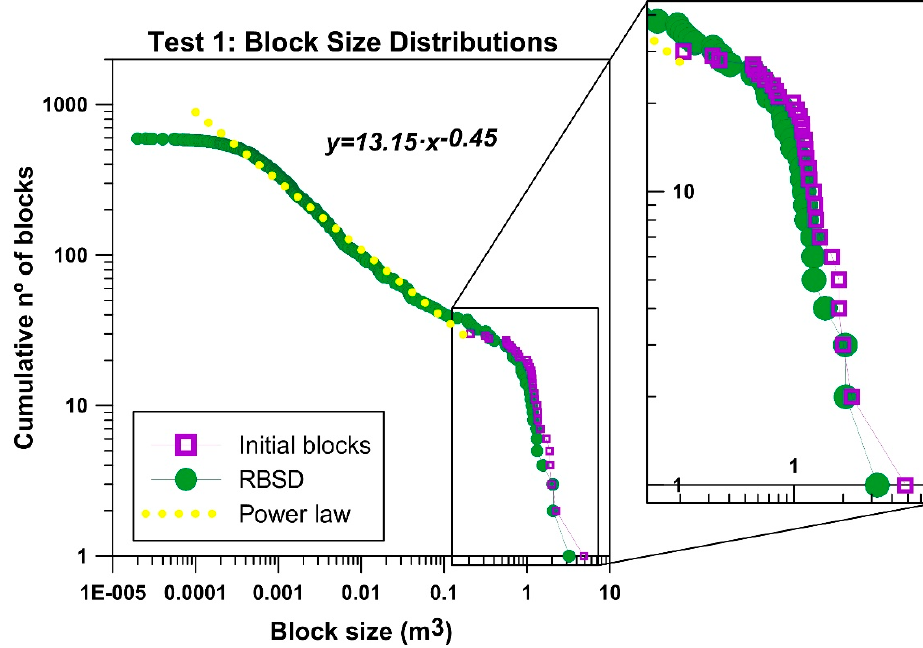
Figure 11. Initial block size distribution (purple) and Rockfall Block Size Distribution (RBSD, all the fragments measured together) obtained in test 1.